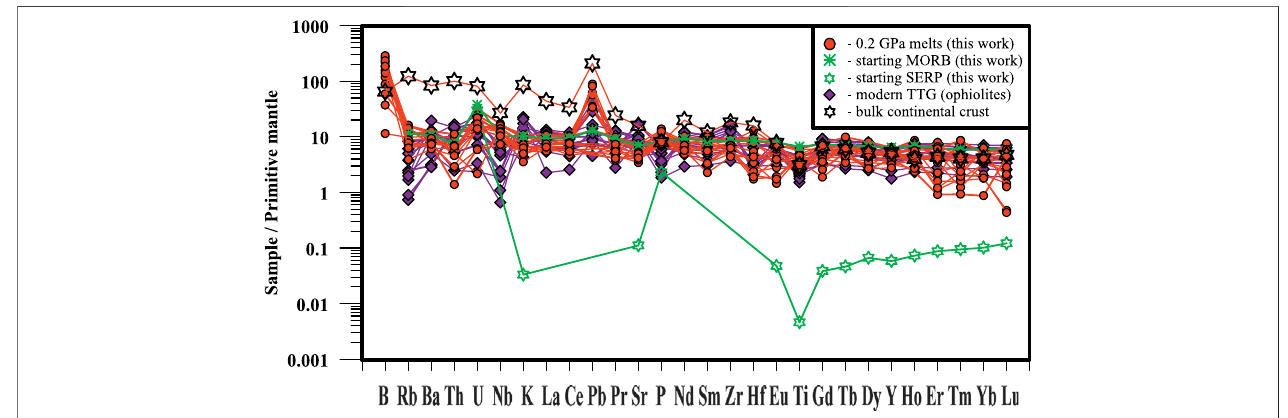
FIGURE 7 | Primitive mantle-normalized trace element abundance patterns of felsic glasses produced at 0.2 GPa during serpentinite-basalt interaction. The primitive mantle compositionis after (Sun and McDonough,1989) and (Lyubetskayaand Korenaga,2007) forB only.Thefelsic glass composition iscompared tobasalt